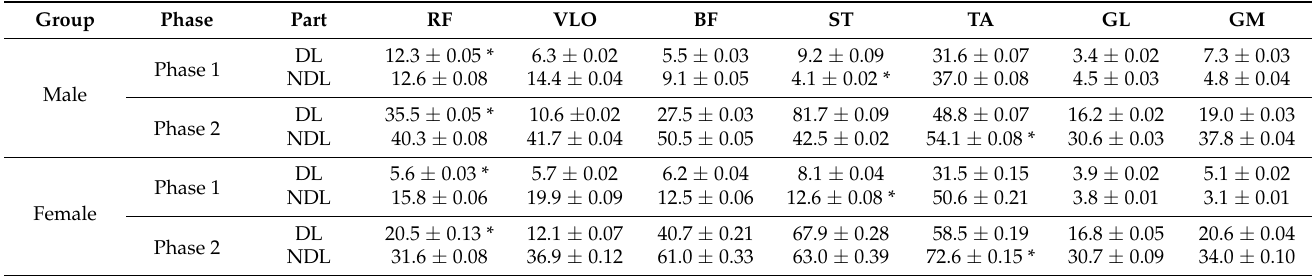
Table 3. Average muscle activation of dominant and non-dominant leg male and female athletes’ reaction time and response time in phases (unit: %RVC).